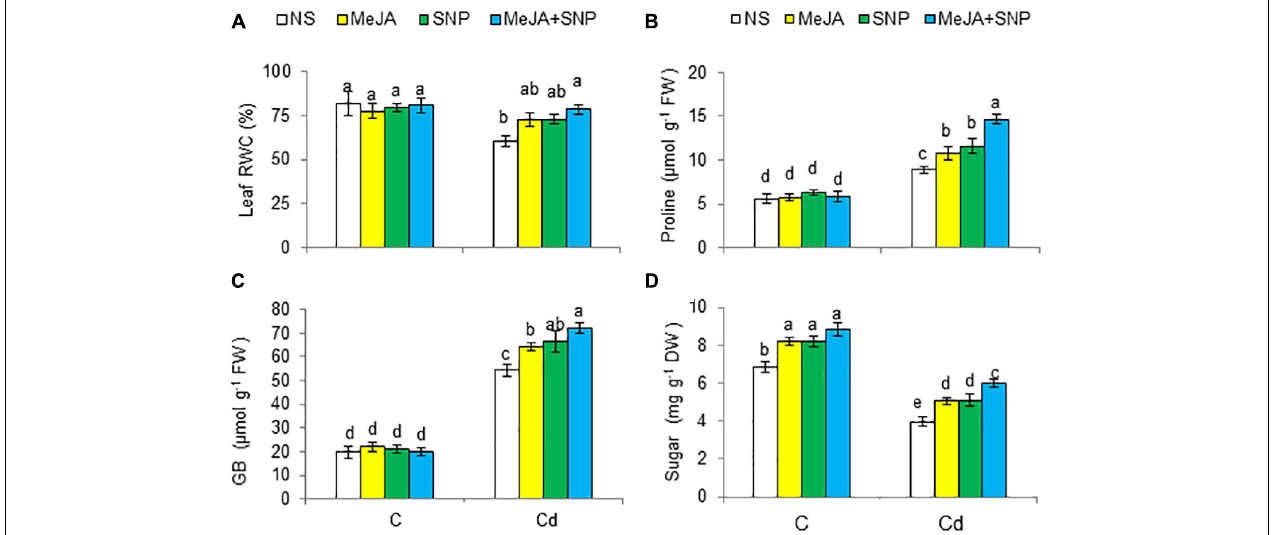
FIGURE 4 | Leaf relative water content [RWC (A) ], proline (B) glycine betaine [GB (C) ] content on fresh weight (FW) basis, and sugar content (D) in wheat plants grown under control (C) and cadmium (100 µ M Cd) and sprayed with 10 µ M methyl jasmonate (MeJA) or 100 µ M sodium nitroprusside (SNP) alone or together (mean ± SE). Mean values carrying different letters within each attribute differ significantly ( P ≤ 0.05) based on Duncan multiple-range test.